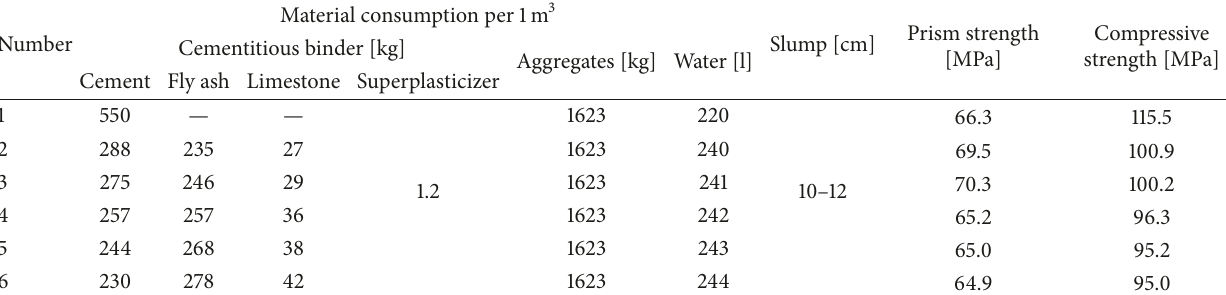
Table 10: Compositions and strength characteristics of the fiber-reinforced concrete.